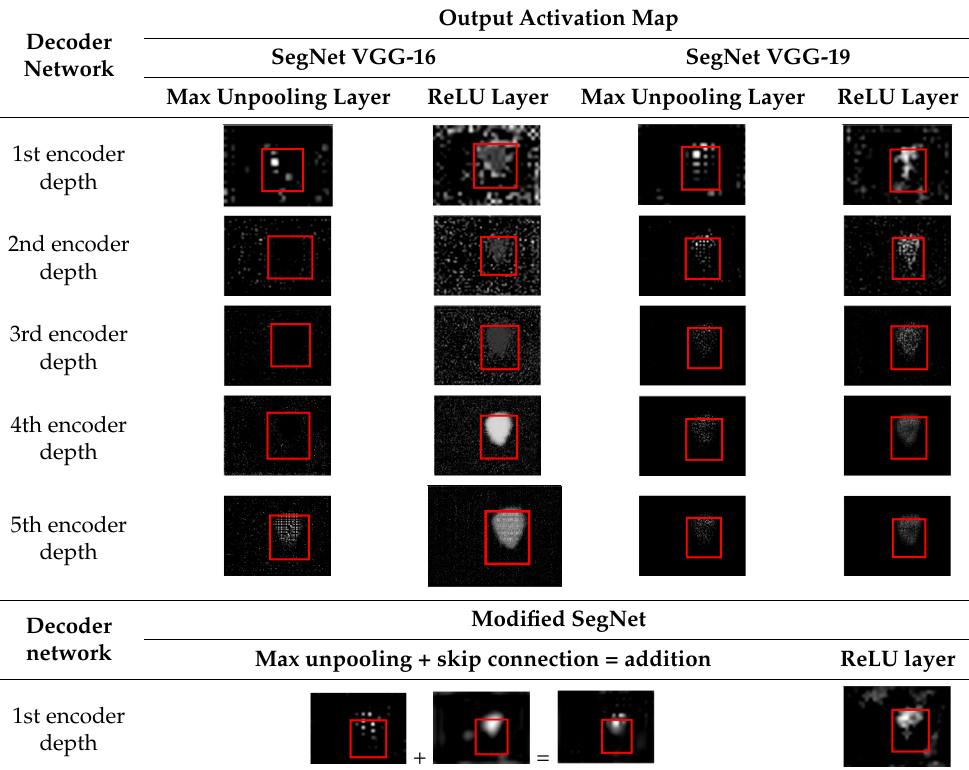
Table A2. Activation visualisation for the max unpooling and ReLU layers at the beginning of all decoder depths, for SegNet VGG-16, SegNet VGG-19, and the modified SegNet, and the skip connection and addition layers at all decoder depths for the modified SegNet. The red boxes in the output activation maps indicate the location of polyps.